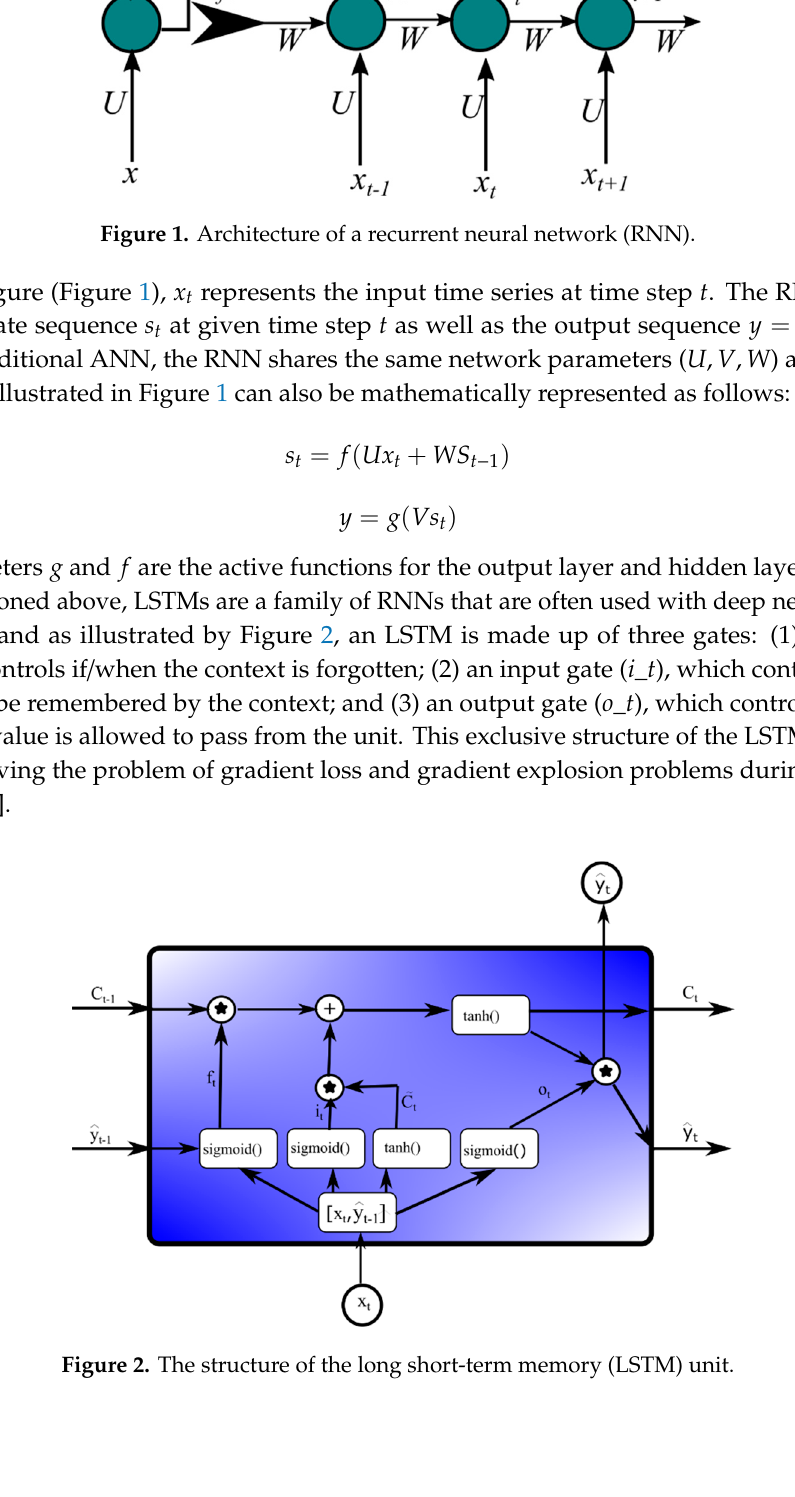
Figure 2. The structure of the long short-term memory (LSTM) unit.